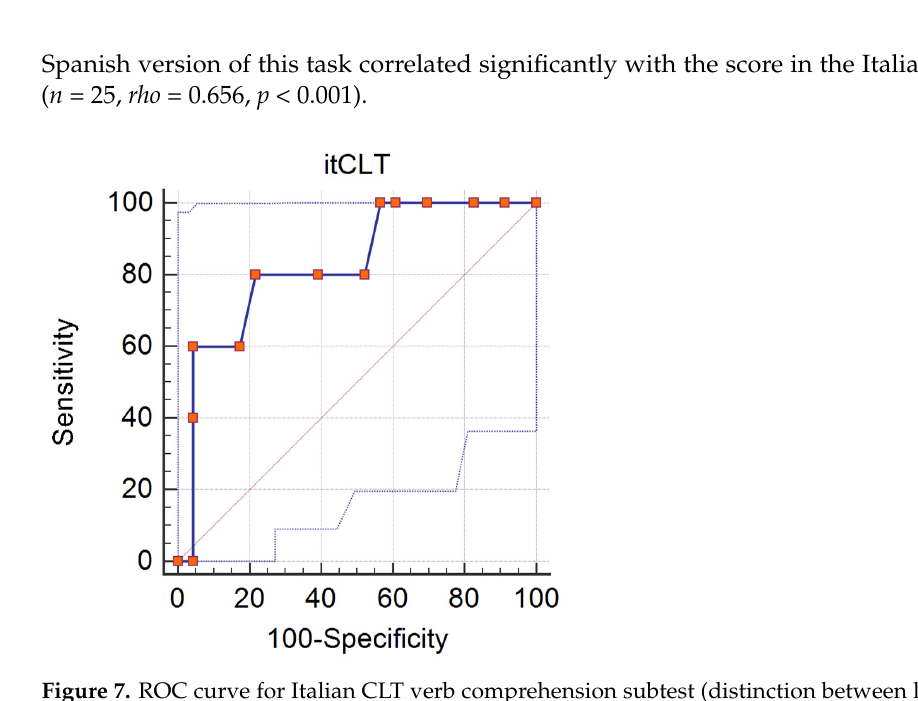
Figure 7. ROC curve for Italian CLT verb comprehension subtest (distinction between lexical risk, n = 5, and no risk, n = 23), AUC = 0.826.